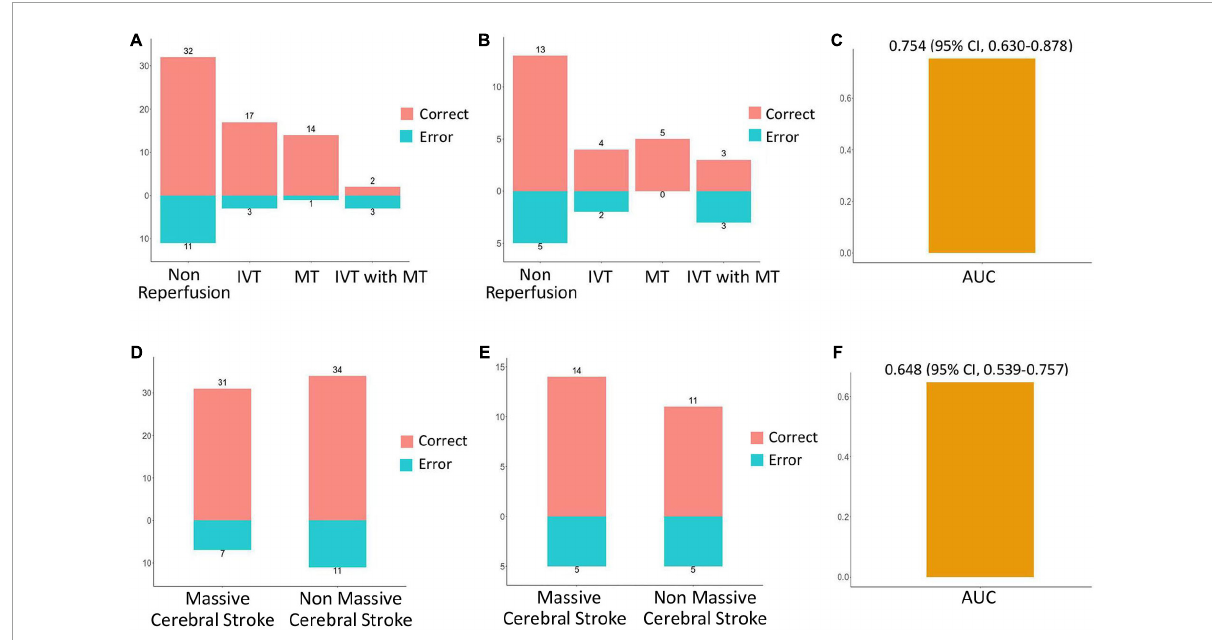
FIGURE6 Performance evaluation of model in different scenarios. In the training cohort (A) and validation cohort (B) , the prediction accuracy of the model for HT in the setting of non-reperfusion therapy, intravenous thrombolysis (IVT), mechanical thrombectomy (MT), and IVT combined with MT therapy. In the training cohort (D) and the validation cohort (E) , the prediction accuracy of the model for HT in the setting of massive cerebral stroke and non-massive cerebral stroke. Red indicates a correct prediction, and blue indicates an incorrect prediction. For all samples, the prediction performance of the model for HT in patients within 4.5 h since stroke onset (C) , and prediction performance for parenchymal hematoma (F)